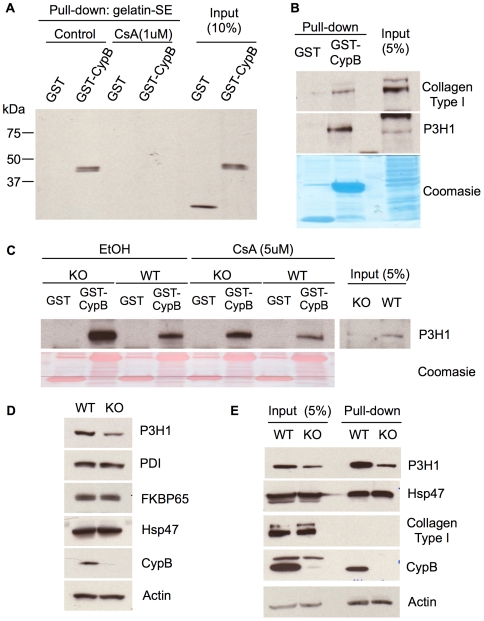
Decreased levels of P3H1 protein in the absence of CypB.(A) GST-cyclophilin B or GST was mixed and pulled down with gelatin sepharose in the absence or presence of cyclosporine A. Proteins were visualized by blotting with antibody to GST. (B) Lysates from wild type cells were mixed with recombinant GST-cyclophilin B or GST, and bound proteins isolated using GSH-agarose prior to SDS PAGE. Proteins were visualized by western blotting with antibodies to the indicated proteins. (C) Binding of GST-CypB to P3H1 in lysates from wild-type (WT) or CypB-knockout fibroblasts (KO) was detected by chromatography on glutathione-agarose followed by western blotting for P3H1. Although P3H1 is present at much lower levels in the absence of CypB, a greater fraction of it binds to recombinant CypB in vitro. (D) Western blot of the indicated proteins from lysates of wild-type and CypB knockout skin fibroblasts. Blotting for beta-actin was performed as a loading control. (E) Proteins from lysates of wild-type and CypB–knockout skin fibroblasts were isolated on gelatin-sepharose. Bound proteins were eluted and detected by western blotting with antibodies to the indicated proteins.